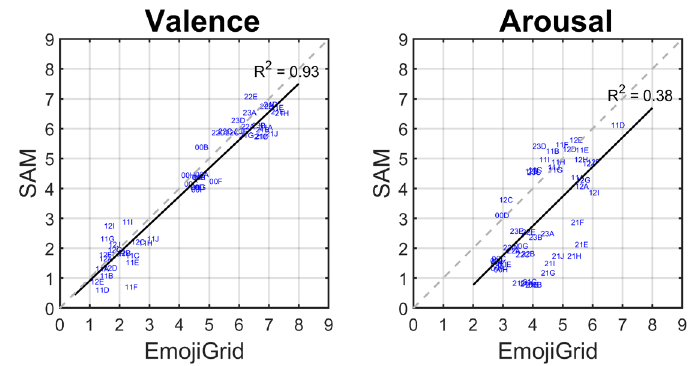
Figure 4. Relation between mean valence (left) and arousal (right) ratings obtained with the SAM and EmojiGrid for 50 affective video clips (Aguado et al. , 2018). Labels correspond to the original identifiers of the stimuli (Yang et al. , 2018 ). The line segments represent linear fits to the data points.